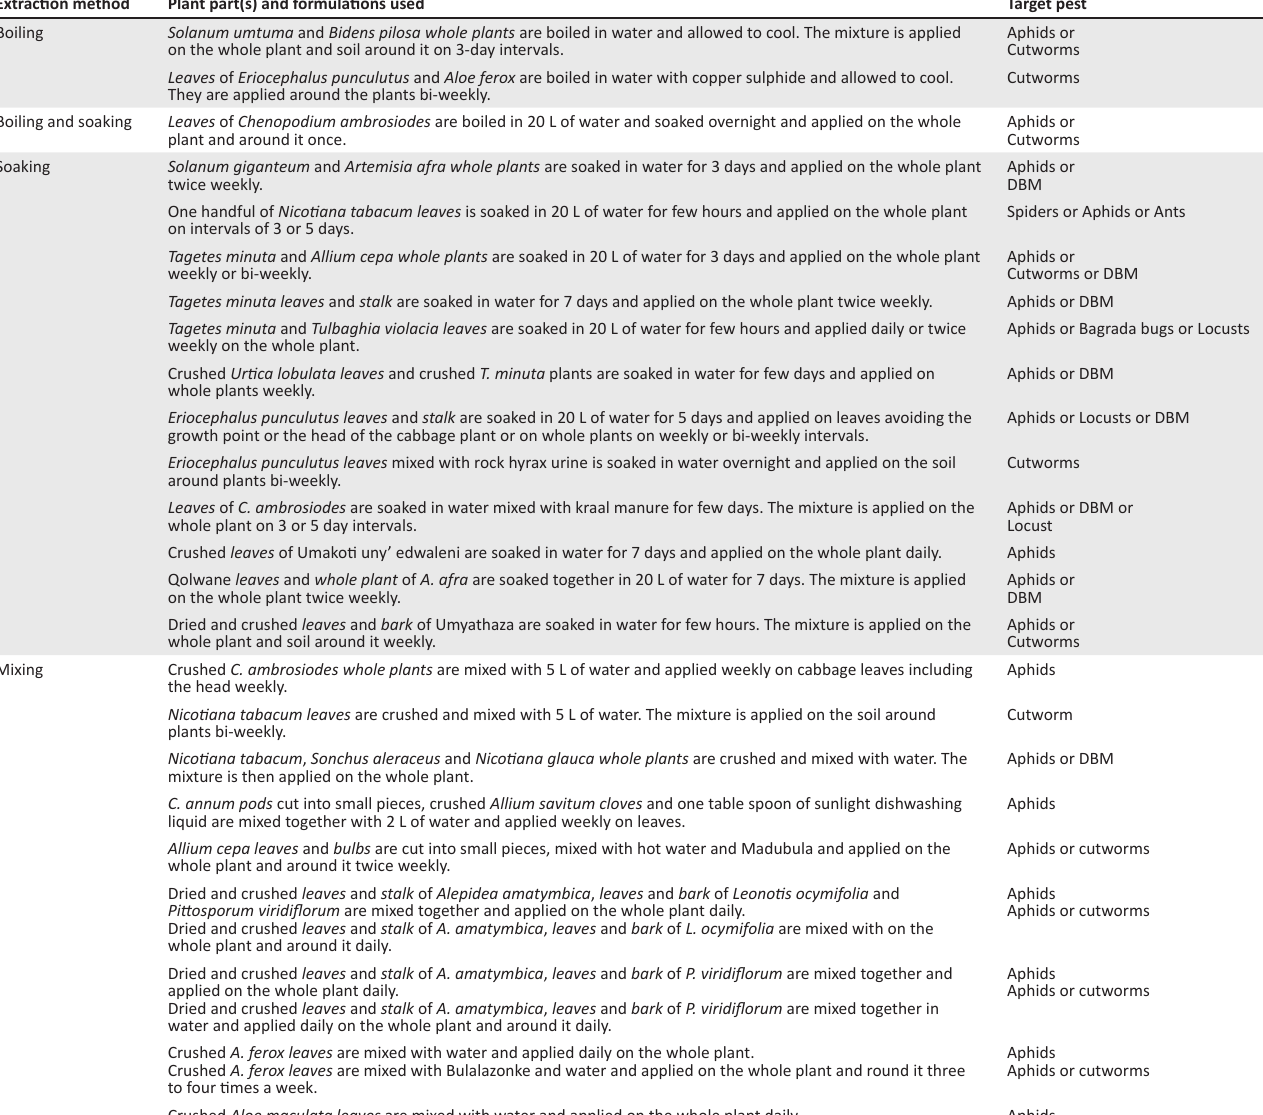
TABLE 3: Preparation methods, plant parts, formulations and combinations used and their corresponding target pest. Extraction method Plant part(s) and formulations used